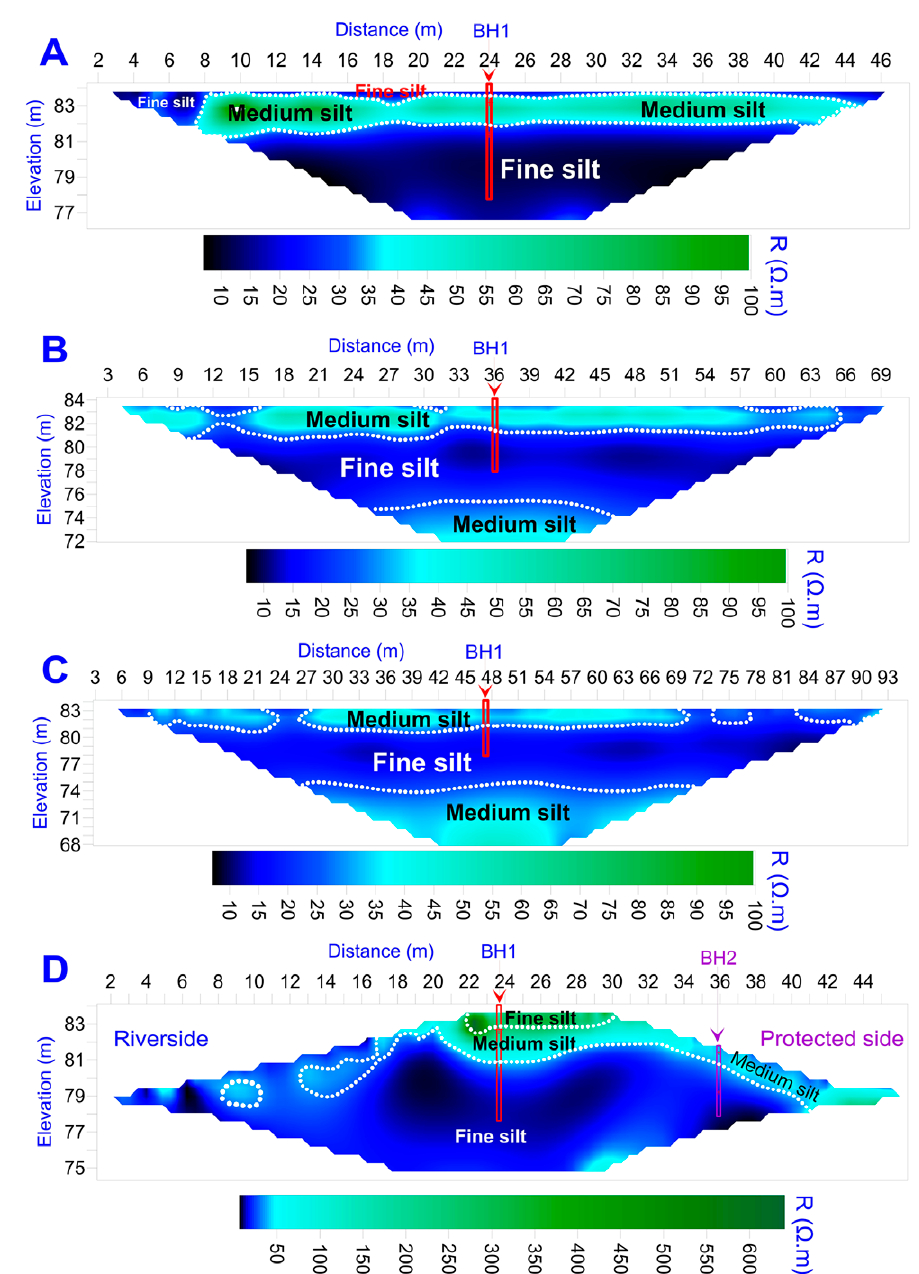
Figure 4. Interpretation of electrical resistivity tomography profiles measured longitudinally